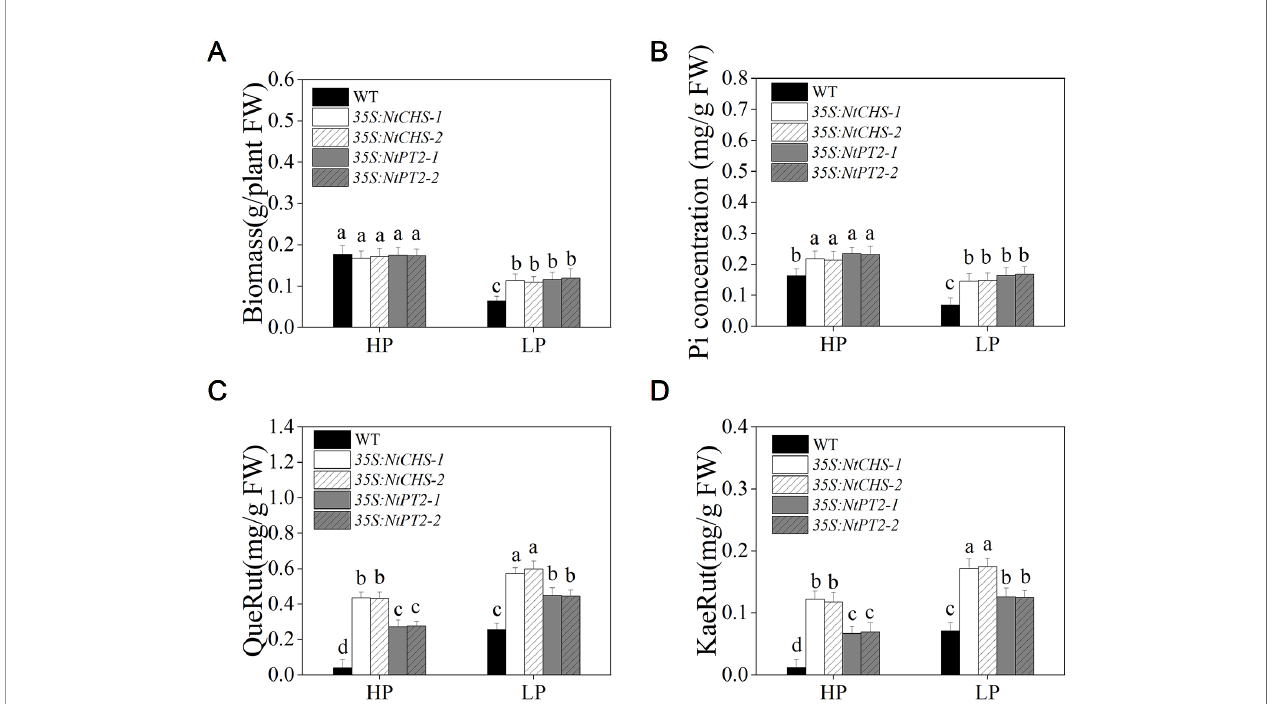
FIGURE 8 | Biomass, Pi concentration, and fl avonol concentration in WT, 35S:NtCHS , and 35S:NtPT2 transgenic plants under HP and LP conditions. (A – B) Biomass and Pi concentration of the WT and transgenic plants under HP and LP conditions. (C – D) QueRut and KaeRut concentrations of the WT and transgenic tobacco plants. Sixteen-day-old seedlings were transferred to the full-strength culture solution and supplied with high Pi (HP; 1mM Pi) or low Pi (LP; 0.02mM Pi) for 14 days. FW, fresh weight. Data are the means ± SDs of three biological replicates. Different letters indicate signi fi cant differences ( P < 0.05).